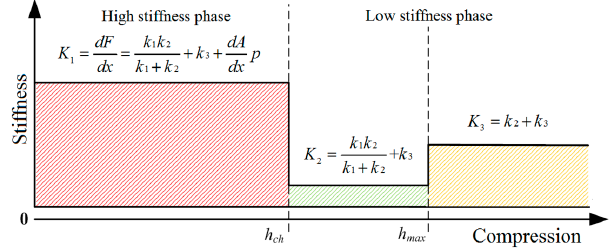
Figure 4. The system stiffness of the PVSU in the entire compression process.